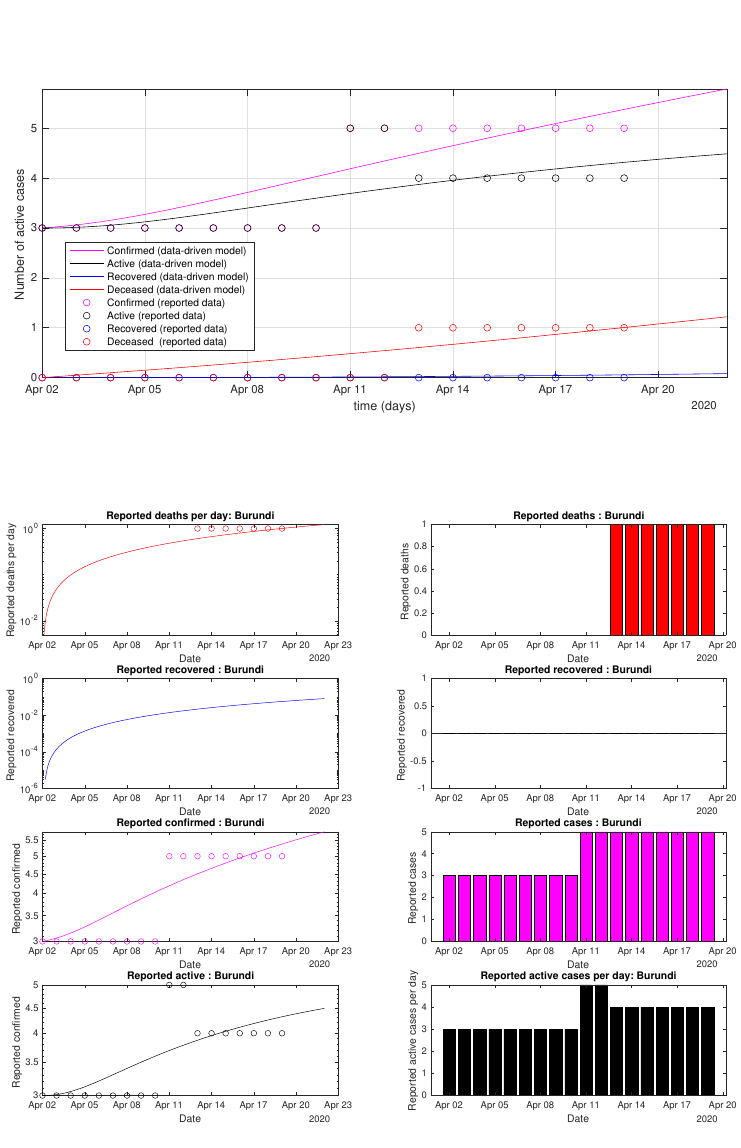
Figure 55. Burundi: data of active, recovered, deceased (in circle or bar) vs. model of active, recovered, deceased over time. Tracking the number of active cases. Predictive analytics for the next couple